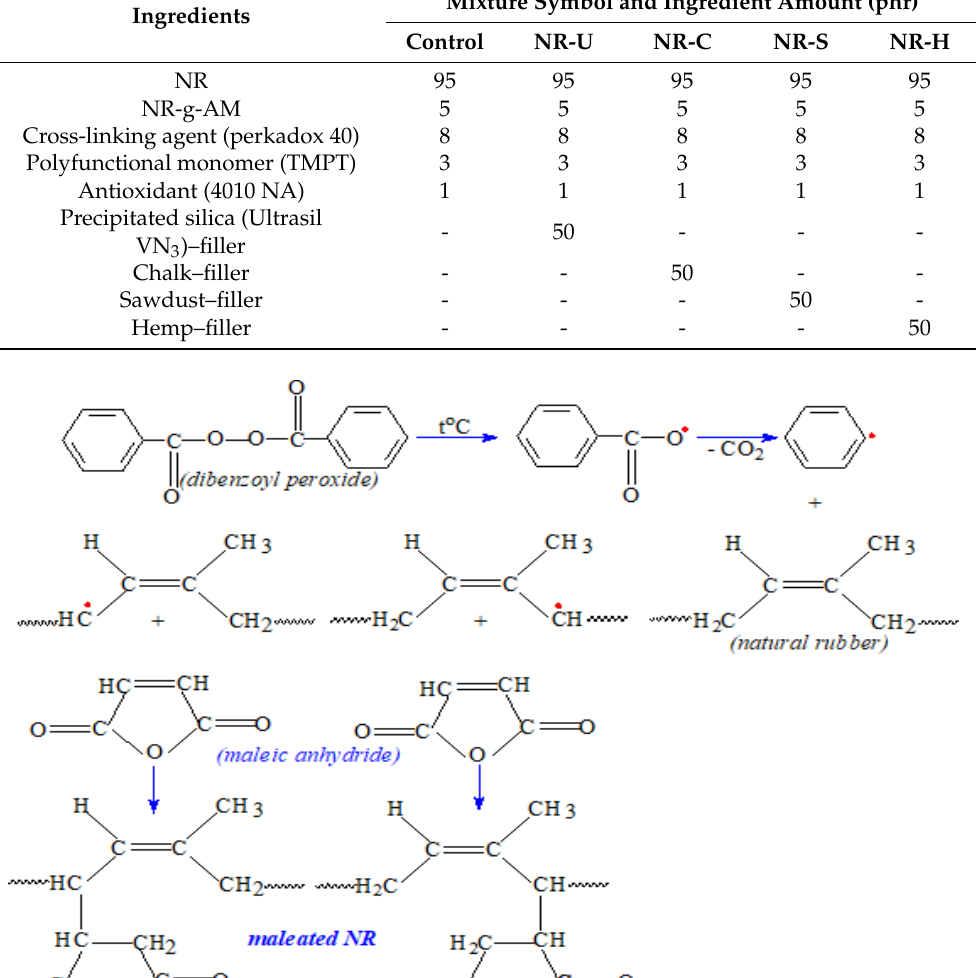
Table 2. The recipes used for the obtaining of elastomeric composites. Ingredients